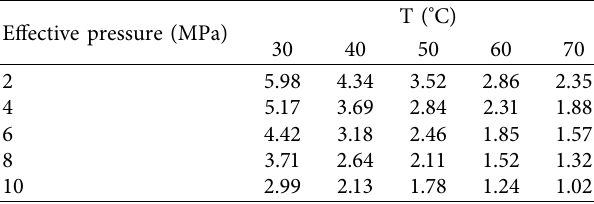
Table 2: The percolation rate of coal under different effective pressure at the pressure of 0.3 MPa.